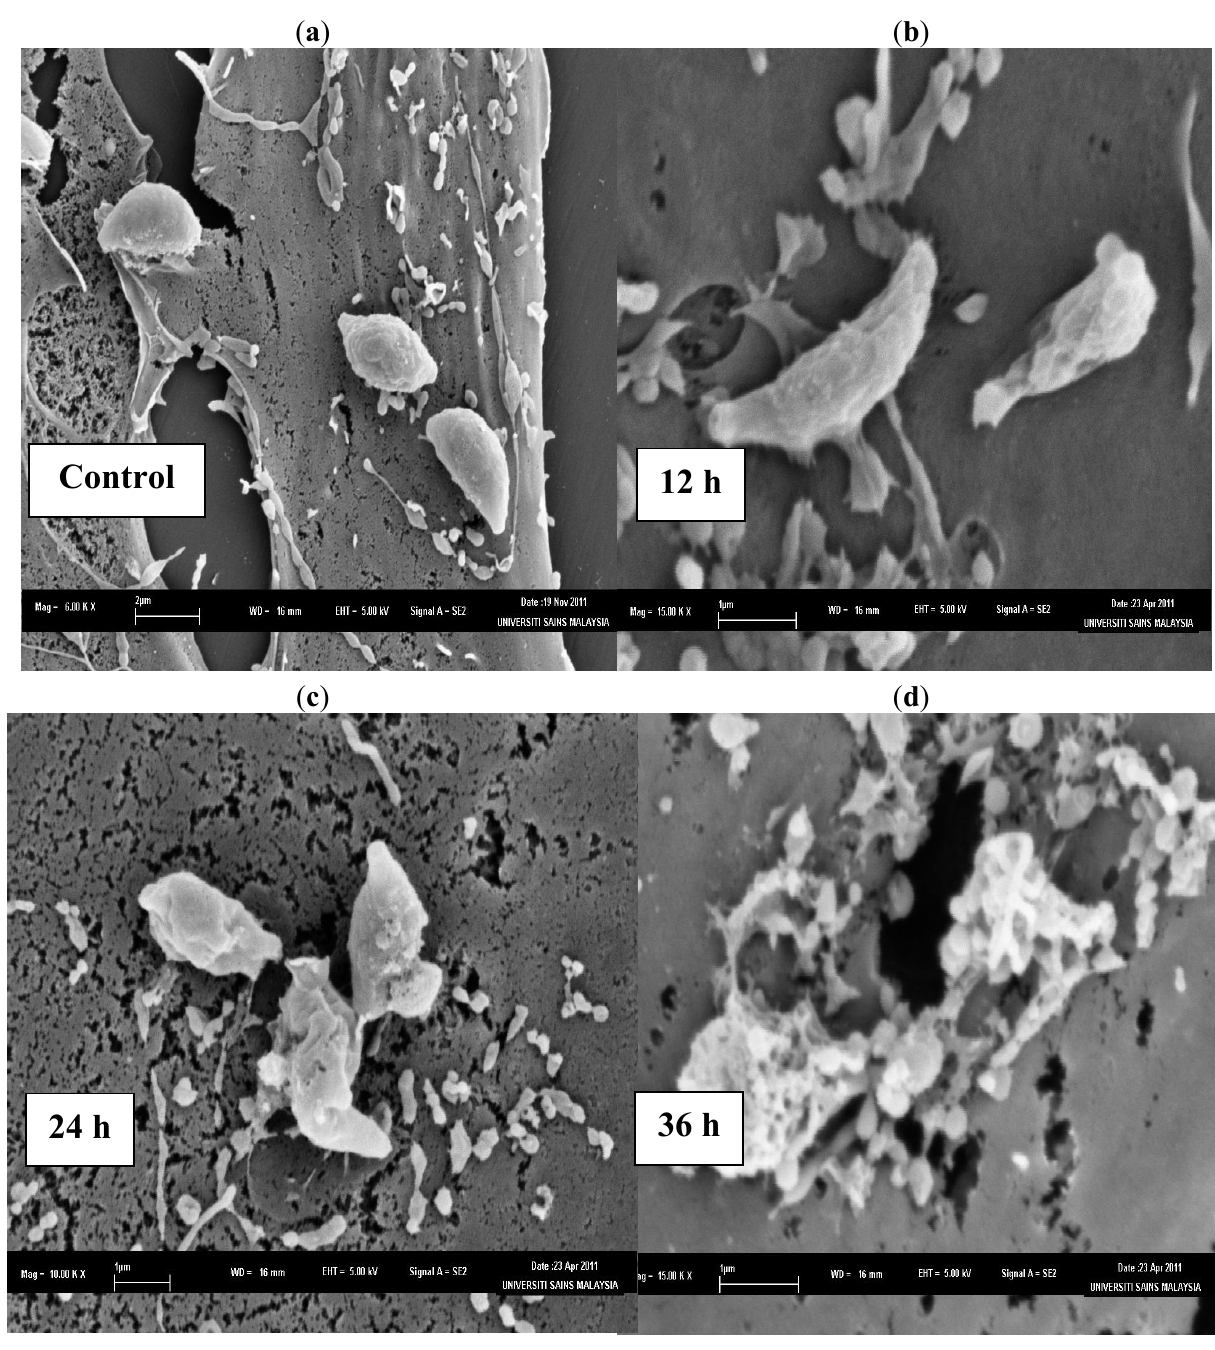
Figure 1. SEM micrograph of the untreated and clindamycin treated cells of T. gondii after different time intervals. ( a ) Untreated cells, ( b ) 12 h of exposure, ( c ) 24 h treated cells, ( d ) 36 h of